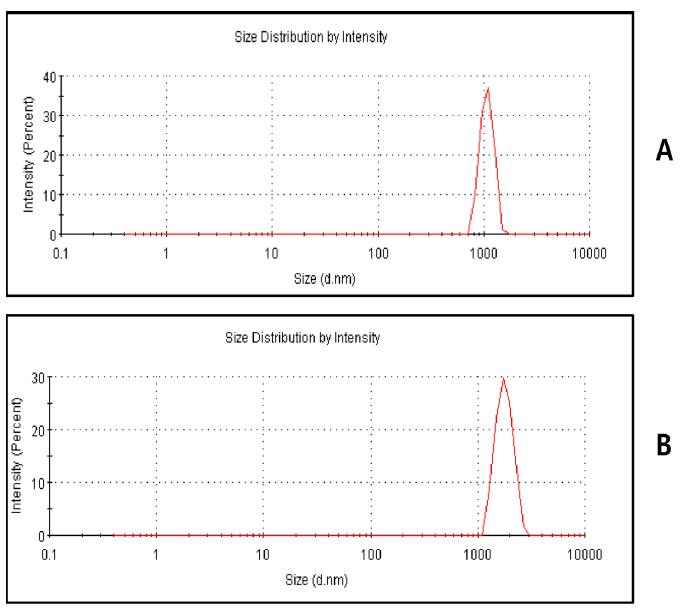
Figure 4. Size distribution analysis of GO and UA-rGO. Aqueous dispersions of GO ( A ) and UA-rGO ( B ) at 250 μ g/mL were characterized by DLS analysis at the scattering angle θ =90° using a particle size analyzer. The data show the average values from triplicate measurements.